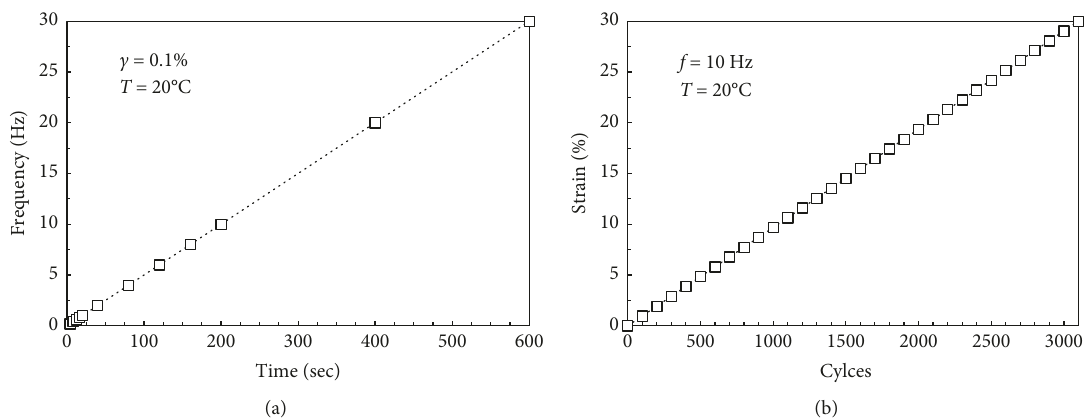
Figure 4: LAS test: 1st phase frequency sweep (a) and 2nd phase amplitude sweep (b).